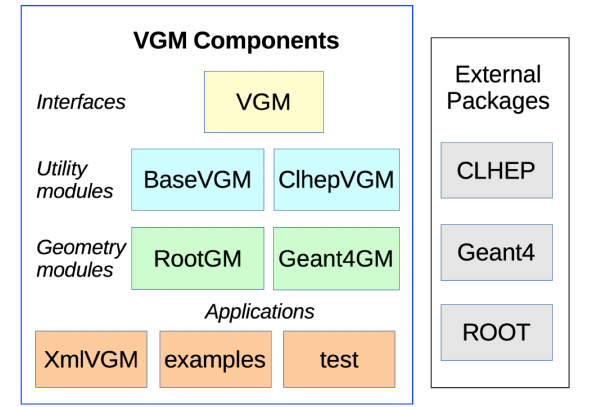
Figure 2. VGM Components Overview